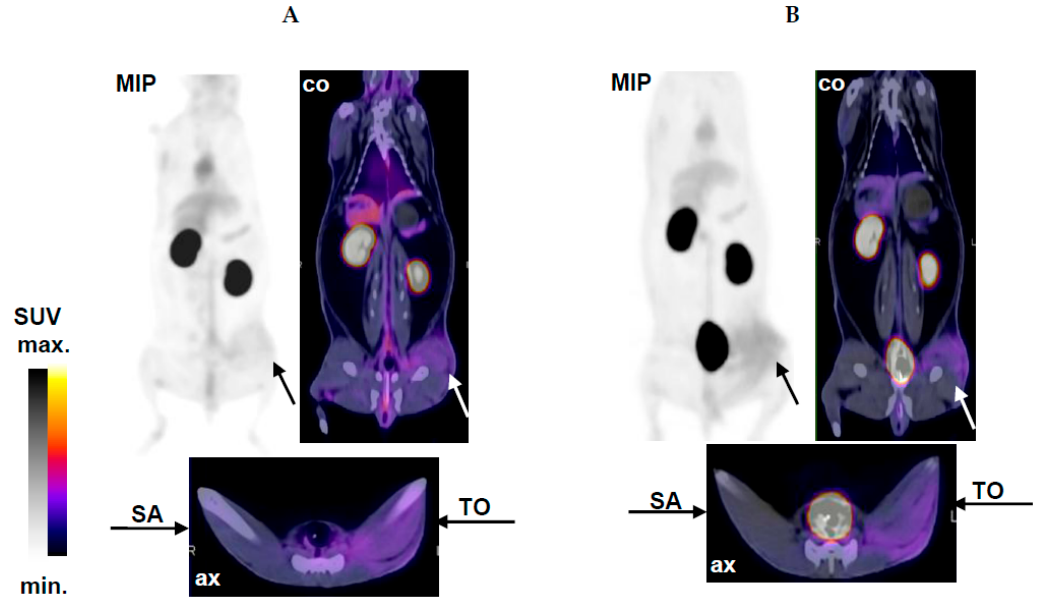
Figure 4. Selective imaging of sterile inflammation and SA infection in NZR2 at ( A ) 5 min and ( B ) 60 min after injection of 68 Ga-DOTA-TBIA101. Arrows highlight the site of sterile inflammation after TO treatment and the contralateral staphylococcal infection site (SA) in a representative midplane-coronal (co) and axial (ax) PET/CT slice and in maximum intensity projection (MIP) PET image.